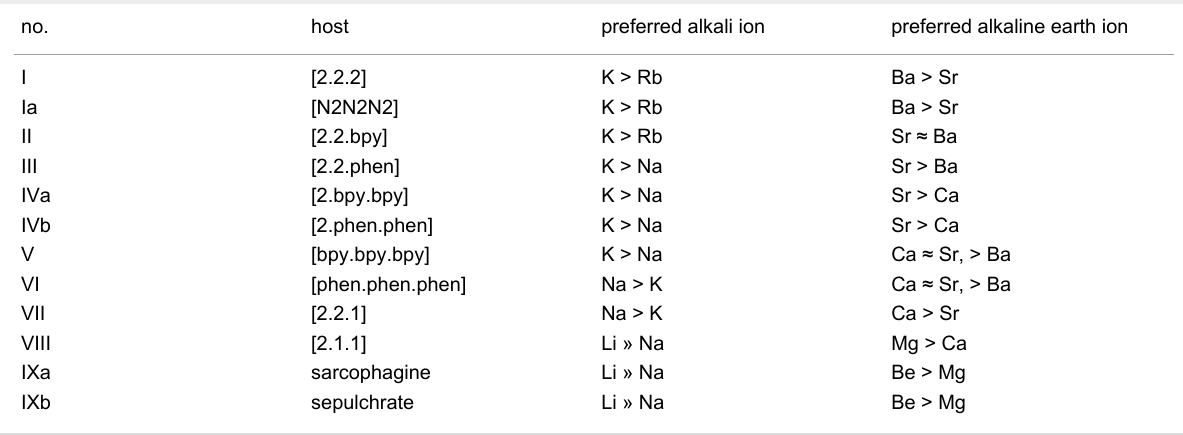
Table 10: Preferred ion selectivity of recently studied cryptands (no.: row number reflecting the cavity size and flexibility of the cryptand).